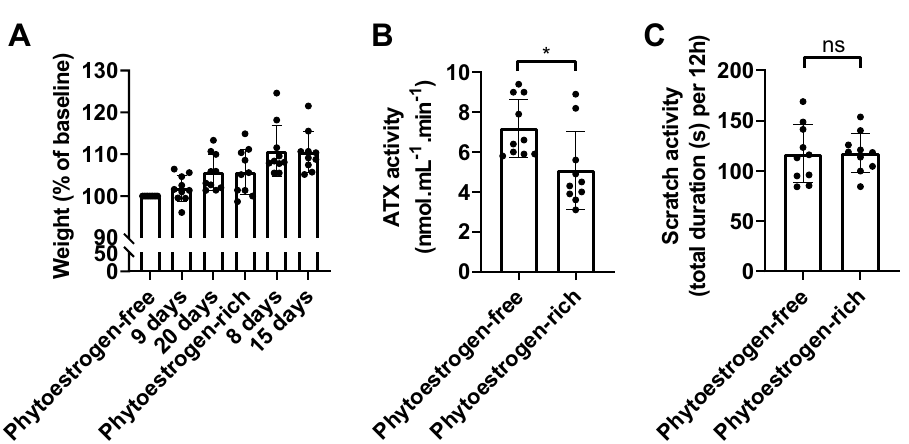
Figure 3. ( A ) Weights (as percentage of baseline), ( B ) ATX activity (after three weeks of phytoestrogen-free and three weeks of phytoestrogen-rich diet), ( C ) scratch activity (mean of four measurements during three weeks) in Atp8b1 mutant mice (n = 10) on phytoestrogen-free and phytoestrogen-rich diet. Bars depict mean ± SD. Statistics: Paired t-test, ns: not significant; * p -value < 0.05.